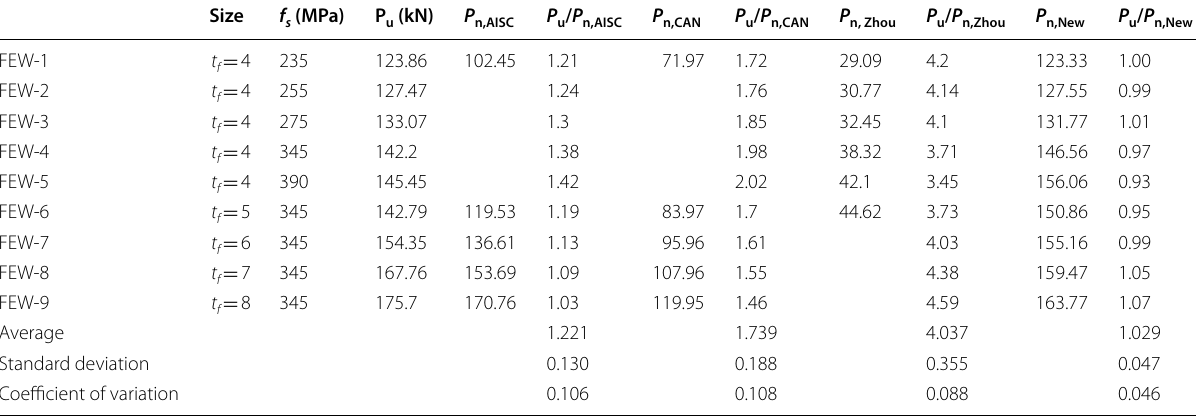
Table 6 Comparison of the theoretical calculations and the simulated